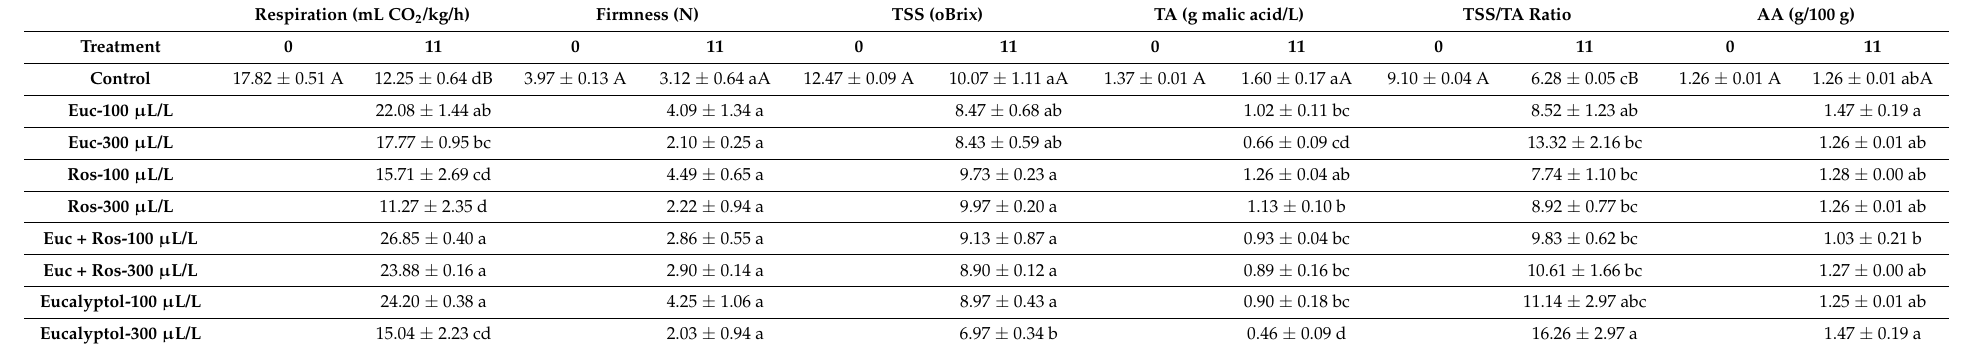
Table 2. Effects of eucalyptus EO (Euc), rosemary EO (Ros), their 50:50 mixture (Euc + Ros) and eucalyptol on quality attributes of inoculated with P. expansum pear fruits stored at 7 ◦ C for 5 days and subsequently at RT up to 11